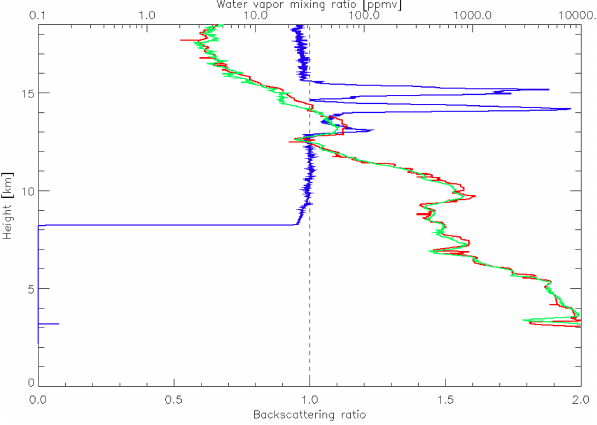
Figure 2. Backscattering ratio (i. e. the ratio between the Rayleigh and the Raman channels at 355 and 387nm, respectively) and WVMR profiles (blue and green curves, respectively) observed dur- ing the night of 8 April 2013, together with the WVMR measured by the co-located RS92 radiosonde (red curve). Both lidar profiles are integrated for 60min starting at the radiosonde launching time (i.e.,